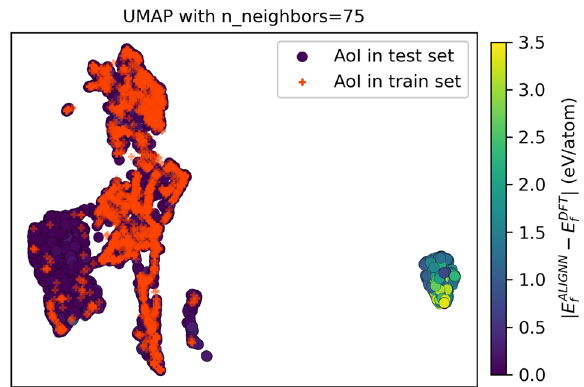
Fig. 6 UMAP projection of the 90-dimensional feature space for the AoI training and test. The X and Y axis are not shown because the two dimensions in UMAP have no particular meanings. For the UMAP projection with only the test data, the reader is referred to Supplementary Fig.